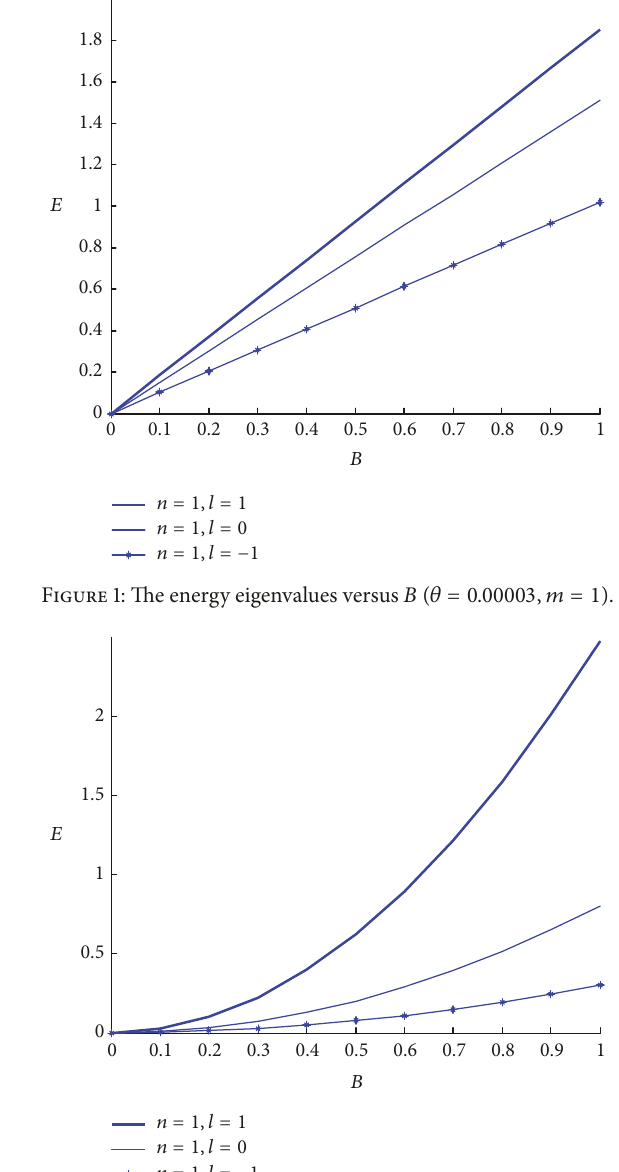
field variable 𝐵 , and the profile shows that the energy